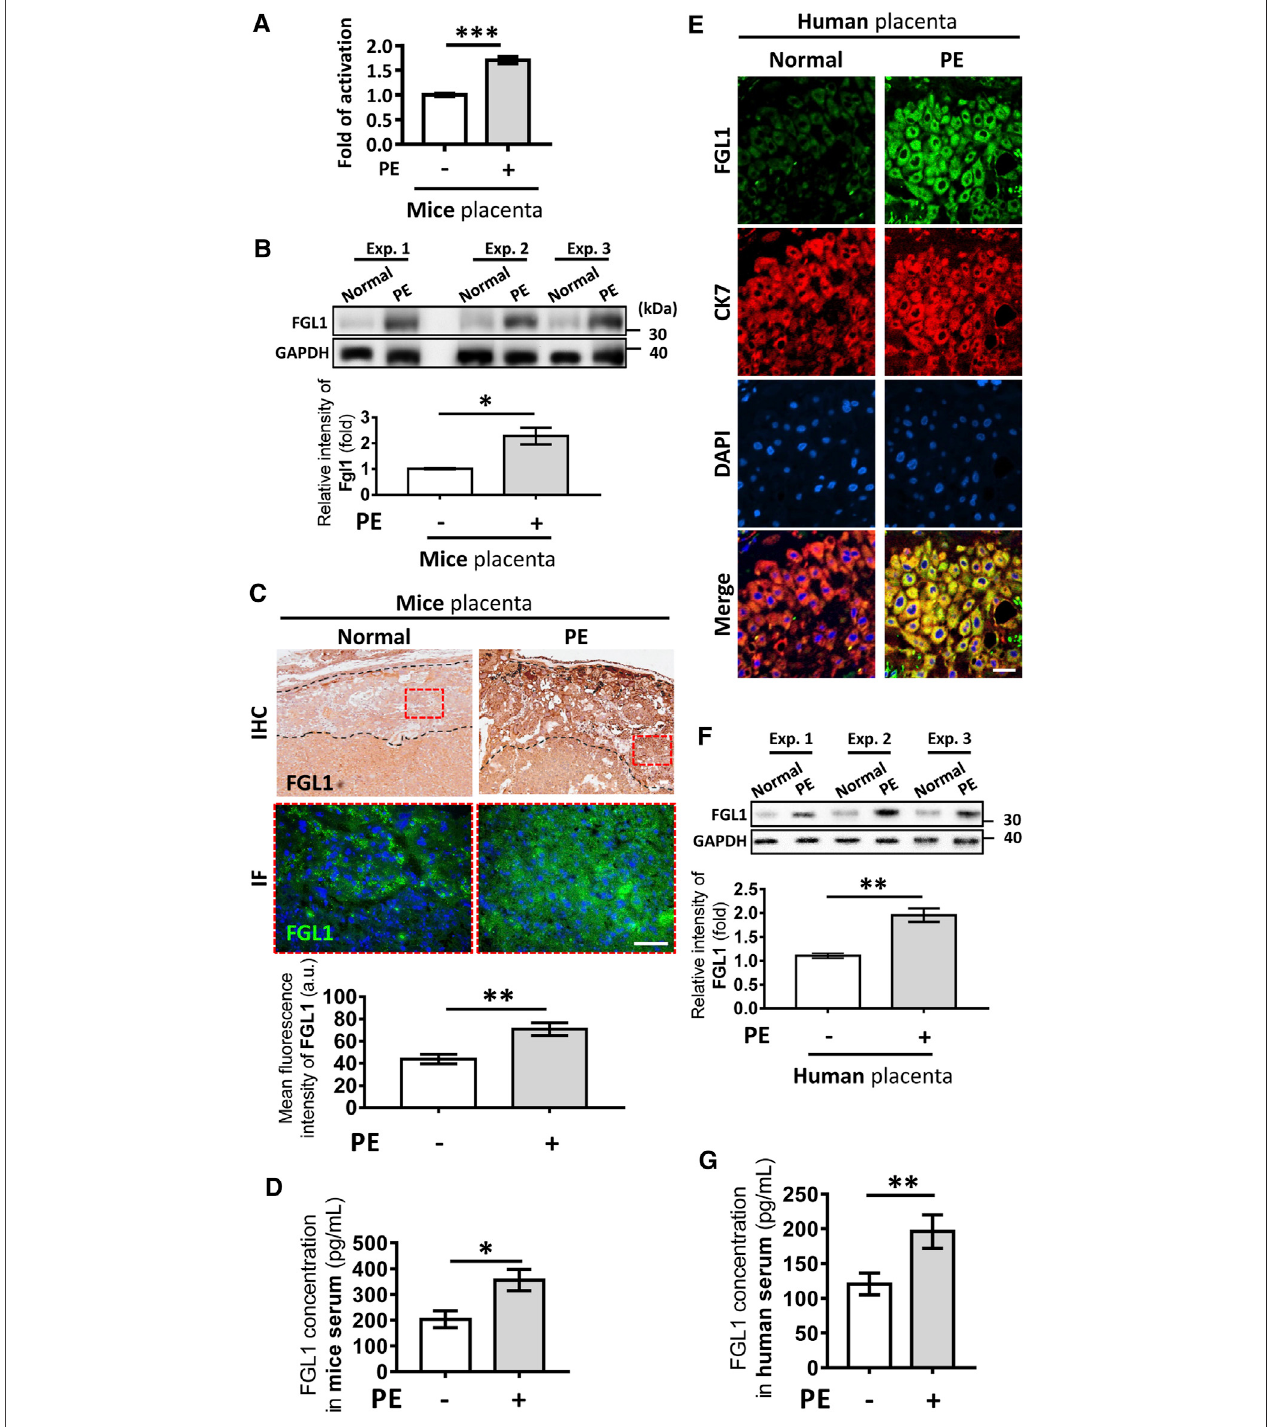
FIGURE 1 | Expression of fi brinogen-like 1 (FGL1) in NG-nitroarginine methyl ester (L-NAME)-induced mouse with preeclampsia (PE) and human placenta and serum. FGL1 mRNA expression levels (A) and FGL1 protein expression levels (B) in the placenta of the mouse with PE and the controls were evaluated using RT-PCR and Western blotting, respectively. Glyceraldehyde-3-phosphate dehydrogenase (GAPDH) was used as a loading control. (C) FGL1 protein expression in mouse placentalsectionswasassessedusingimmunohistochemistry(IHC)andimmuno fl uorescence(IF)staining.Thedottedblackareaindicatedthedecidua;thedotted red rectangle indicated the picture area of IF. Brown and green indicates FGL1; blue indicates cell nuclei. Scale bar, 200 μ m. Photographs were obtained from the placentajunctionalzone. (D) SerumFGL1concentrationwasanalyzedinthePEandnon-PEgroupsusingenzyme-linkedimmunosorbentassays(ELISAs), n (cid:1) 6/group.